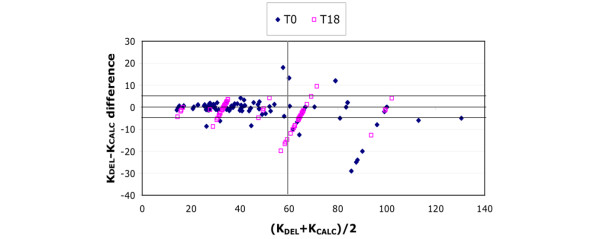
Bland–Altman correlation between urea clearance obtained by two methods: urea clearance calculated with the described software (KCALC) and urea clearance obtained by direct measure on prefilter blood and effluent samples (KDEL). It is possible to distinguish the correlations between KCALC and KDEL, at therapy start (T0) and after 18 to 24 hours of uninterrupted therapy (T18).